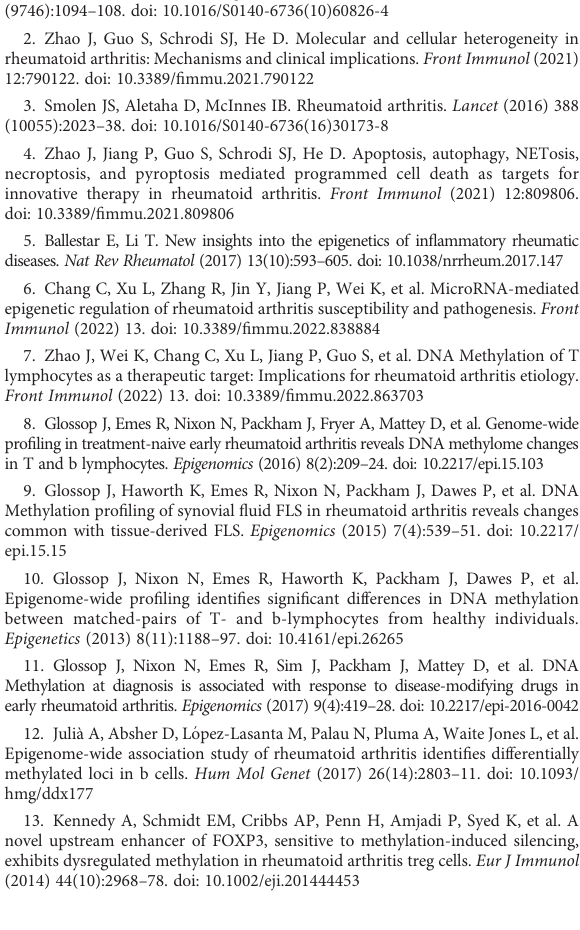
SUPPLEMENTARY FIGURE 1 Speci fi cityandaccuracyoftheproportionofhaplotypesofcg15692052in combination with RF or CCP for the diagnosis of RA. Logstic regression models were constructed and ROC curves were plotted, with the AUC area representing the accuracy and speci fi city of the diagnosis. CCP, anti- cyclic peptide containing citrulline; RF, rheumatoid factor;combanation, different haplotypes combined with RF or